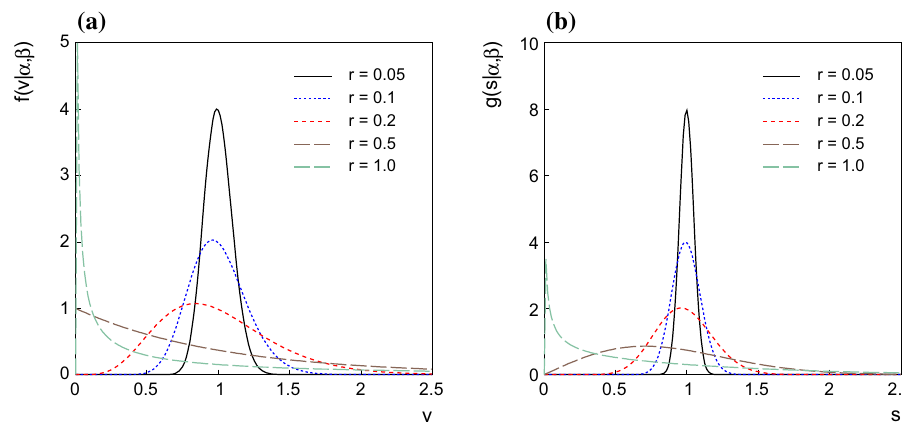
Fig. 1 Plots of a the gamma distribution of the estimated variance v and b the Nakagami distribution for the estimated standard deviation s =